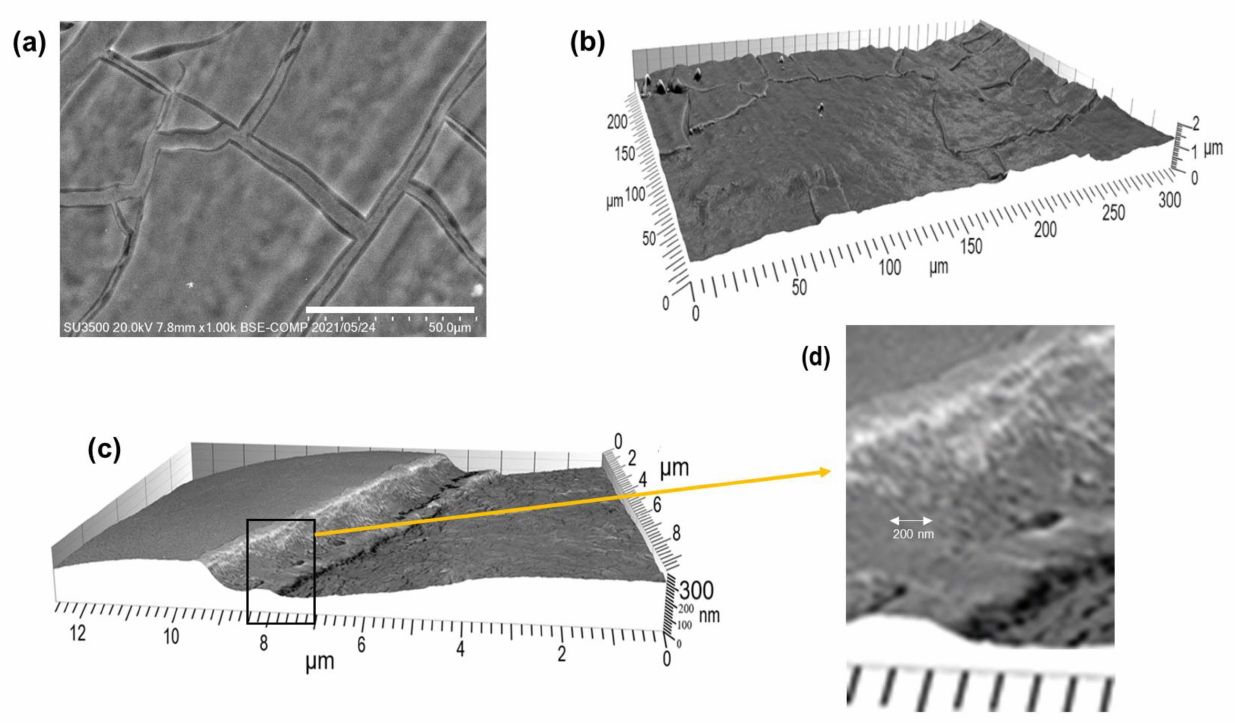
Figure 6. SEM observations of the coated area after the dissolution of SiO 2 under ( a ) magnification 1 × K. 3D image at the edge part of coated area after leaching. ( b ) Magnification 1 × K, ( c ) magnification 10 × K, and ( b ) partially enlarged view of ( c